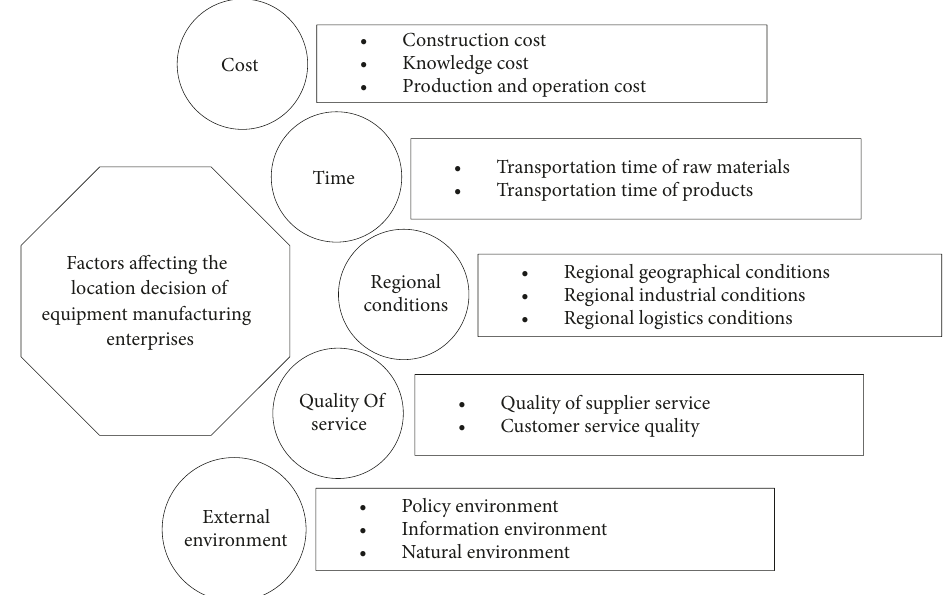
Figure 3: The structural model of the location decision-making influencing factors.